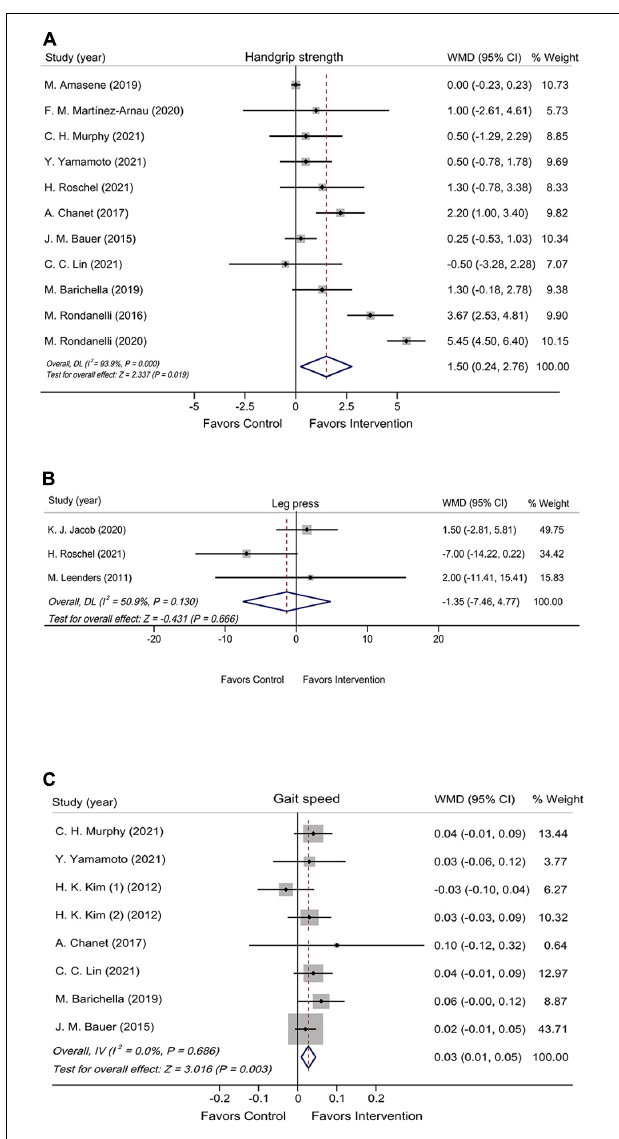
FIGURE 2 | Forest plots assessing the effect of leucine-isolated/combined supplementation on handgrip strength (A) , leg press (B) , and gait speed (C) .